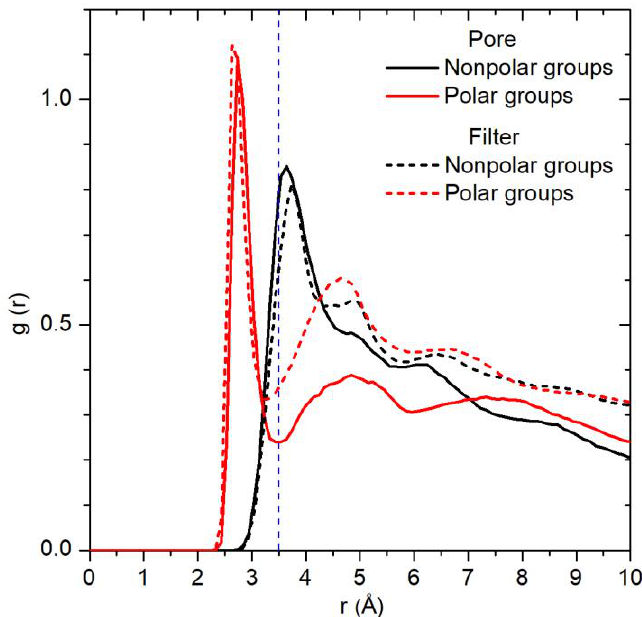
Figure 3. Radial distribution functions of water oxygens around polar and nonpolar groups of the pore and filter domains. The most hydrated groups of Gly643, Met644, Gly645, Asp646 (filter) and Tyr671, Asn676, Ile679, Ala680 (pore) were taken for calculation. r = 0 corresponds to the position of the central atom of a group (oxygen or nitrogen for polar groups and carbon for nonpolar groups). Dashed vertical line shows the radius of 3.5 Å around the protein groups.